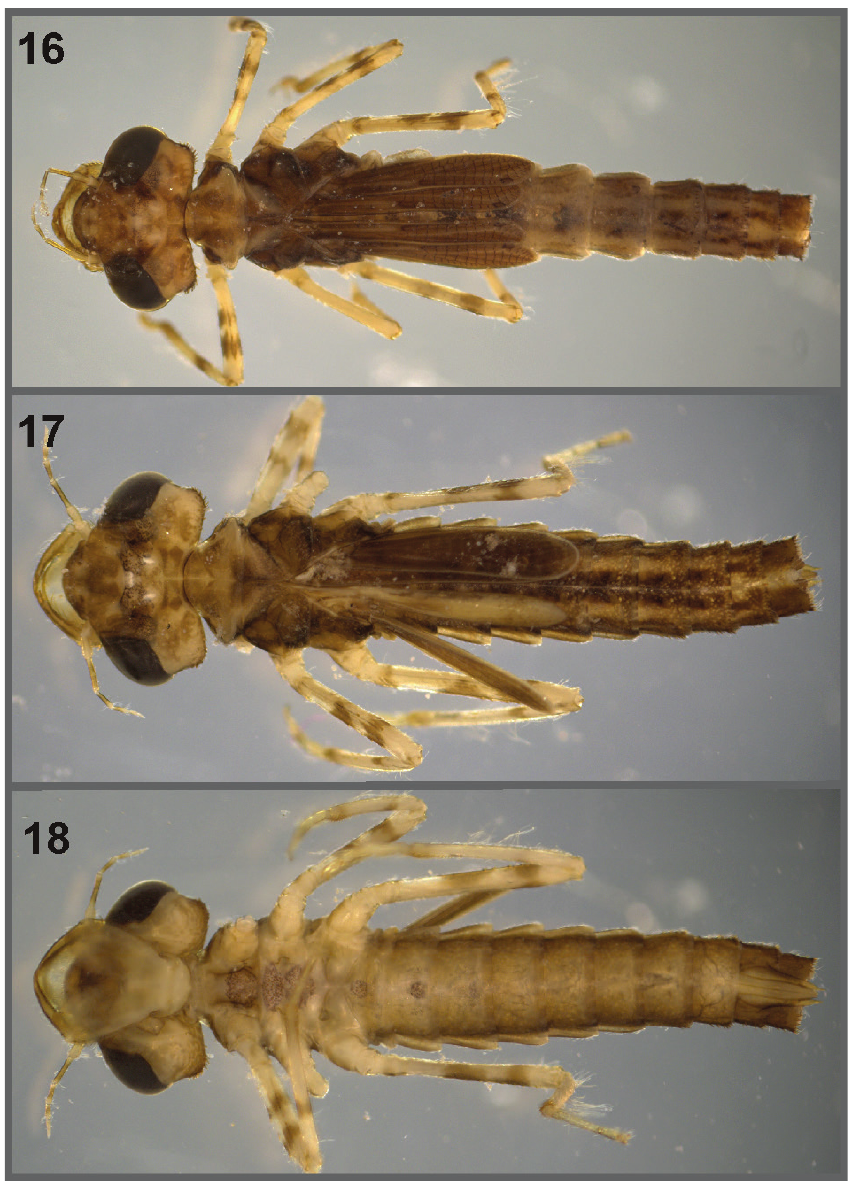
Figures 16-18 - Neoneura confundens , last instar larva, habitus: 16 , male, dorsal view; 17 , female, dorsal view; 18 , female, ventral